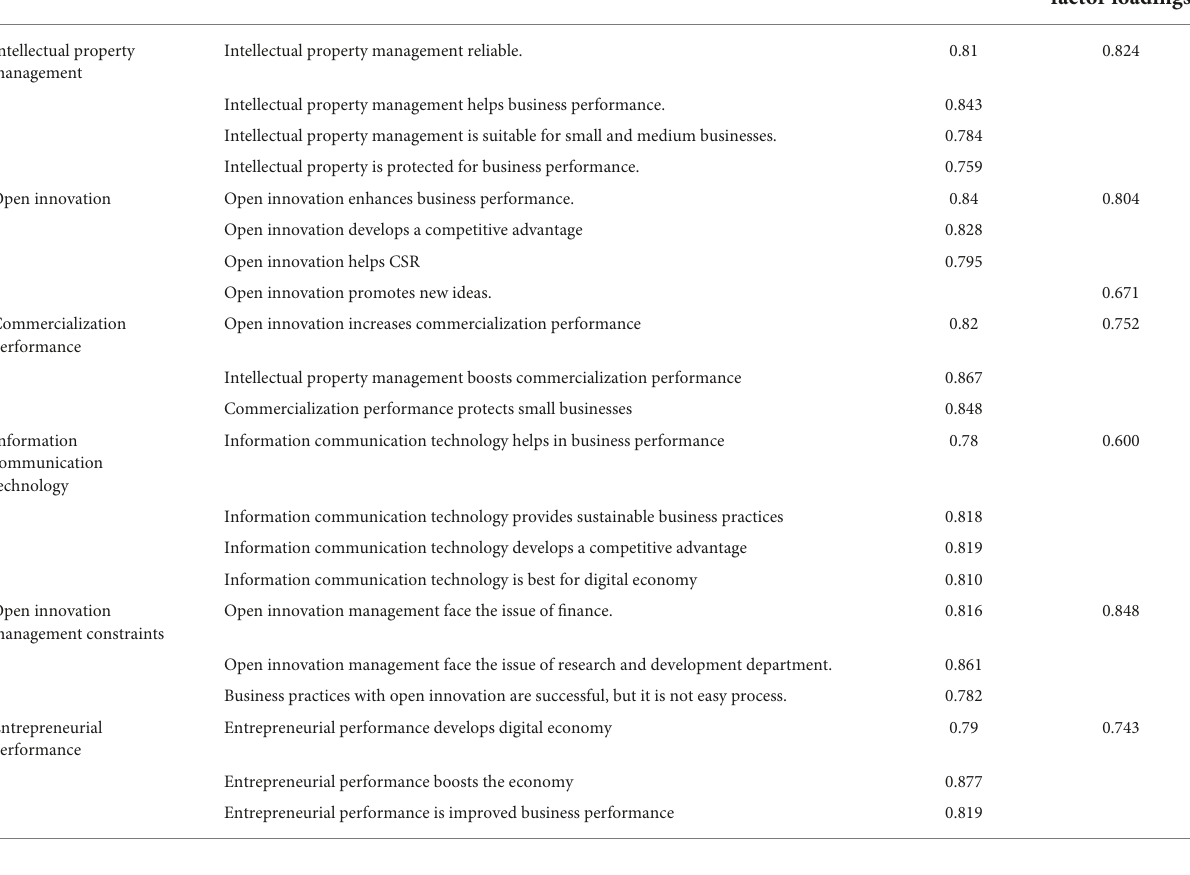
TABLE 1 Results of confirmatory factor analysis.